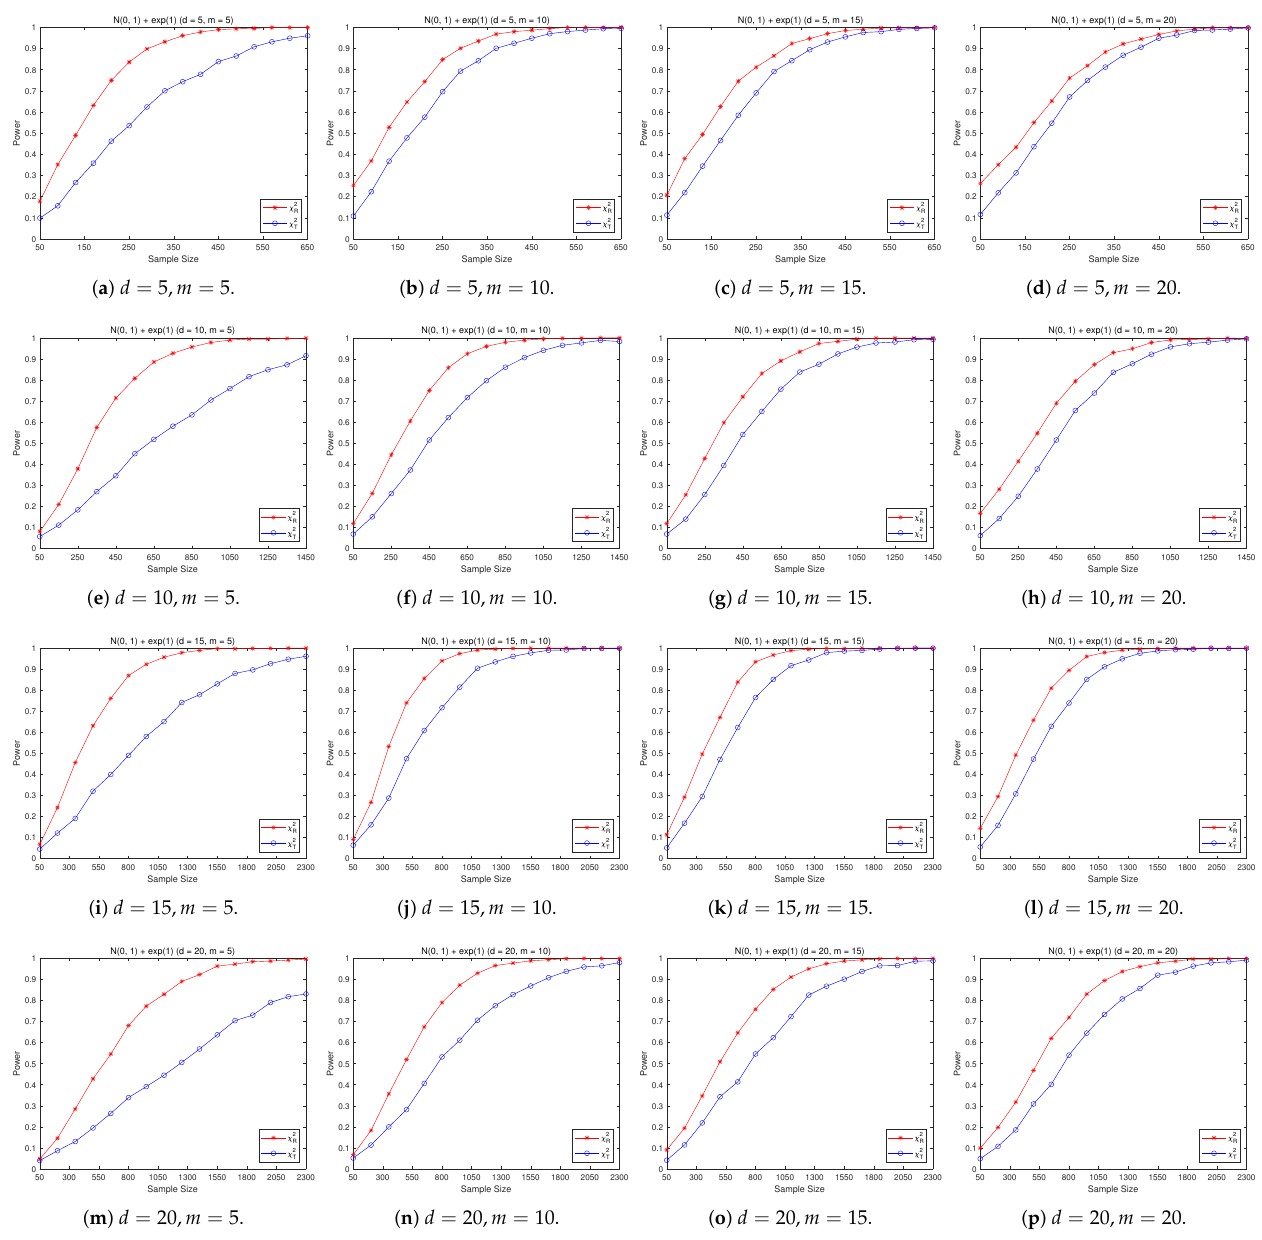
Figure 8. The distribution N ( 0,1 ) + exp ( 1 ) . Red line for RP-chi-square, blue line for traditional chi-square.